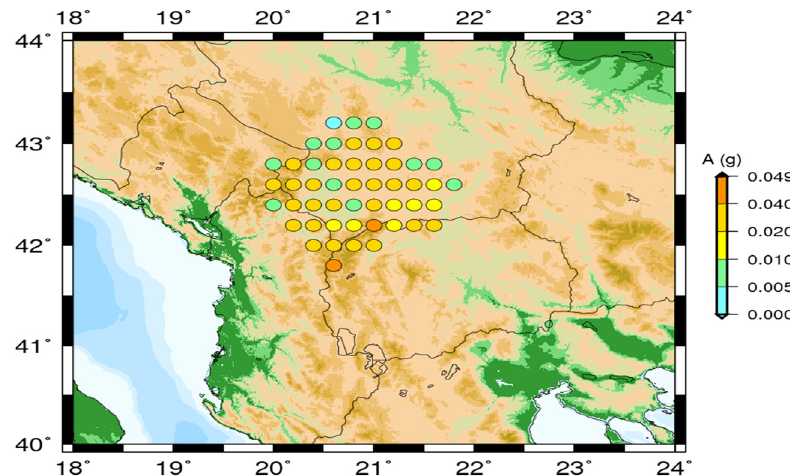
Figure 2: Peak value of